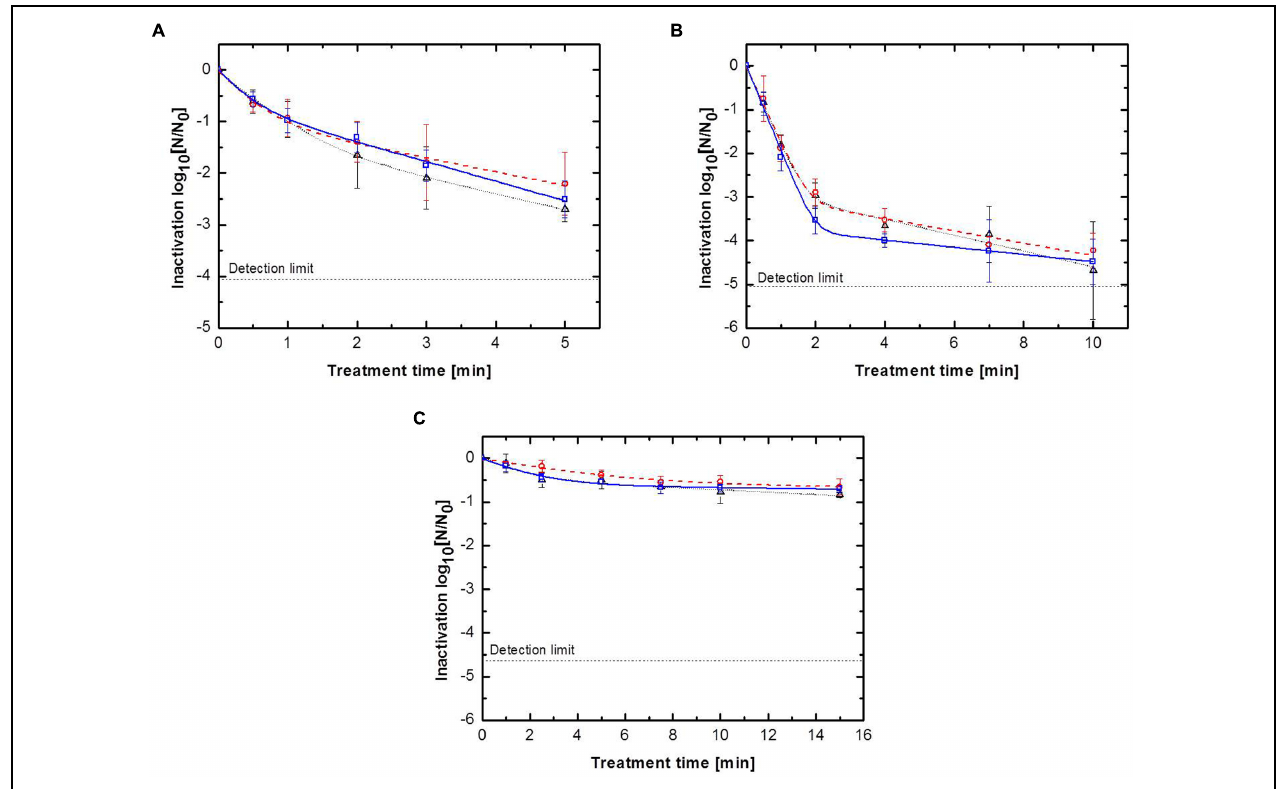
FIGURE 2 | Inactivation kinetics for Bacillus subtilis endospores for ( (cid:3) ) pure argon, ( (cid:4) ) argon + 0.135% vol. oxygen, ( (cid:2)(cid:2)(cid:2) ) argon + 0.135% vol. oxygen + 0.2% vol. nitrogen inoculated on: (A) glass petri-dishes, (B) glass beads and (C) peppercorns, with biphasic